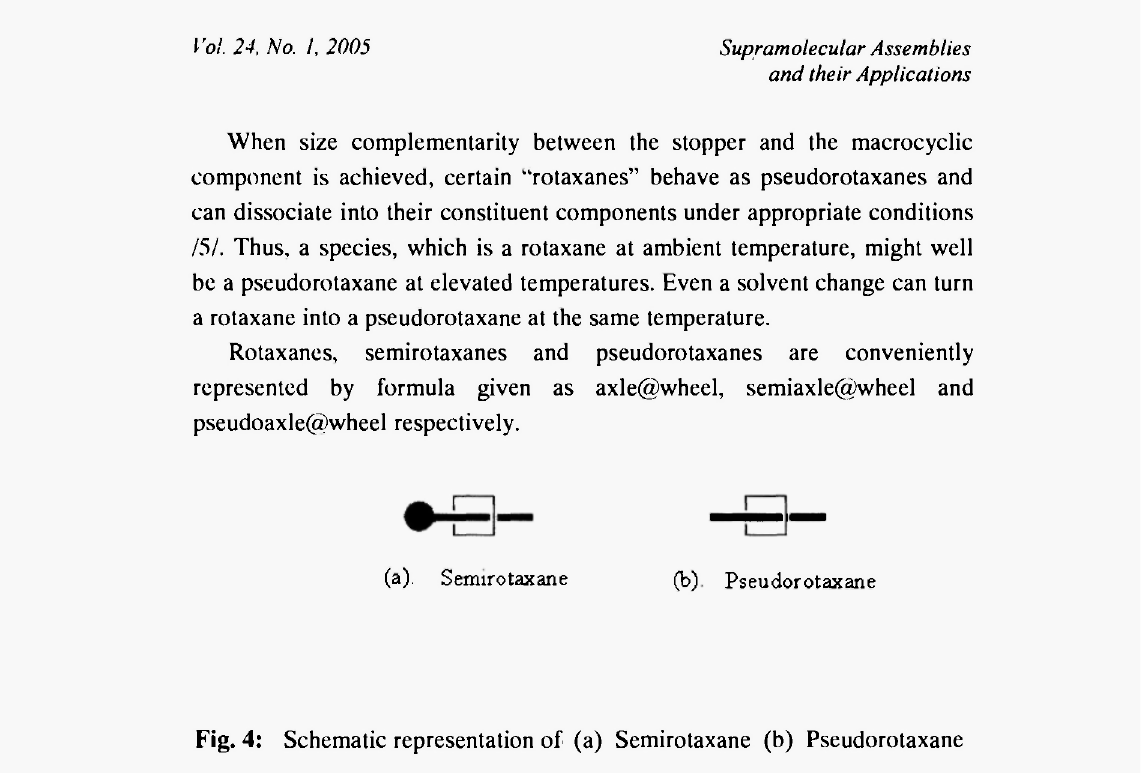
Fig. 4: Schematic representation of (a) Semirotaxane (b)